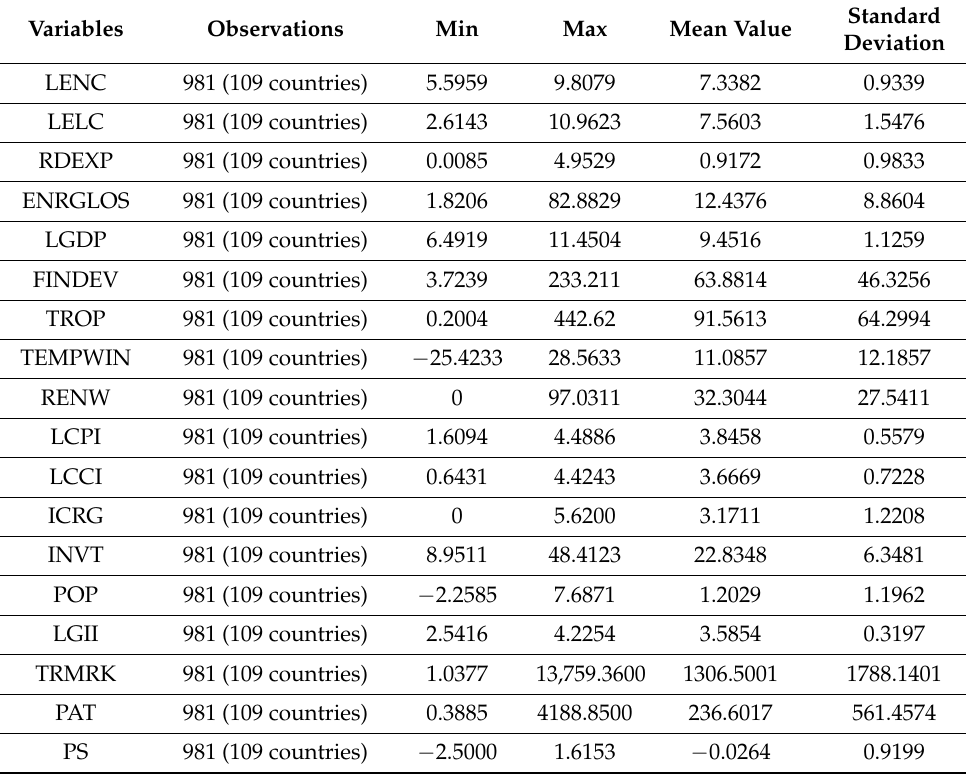
Table A1. Statistical characteristics and summary statistics.